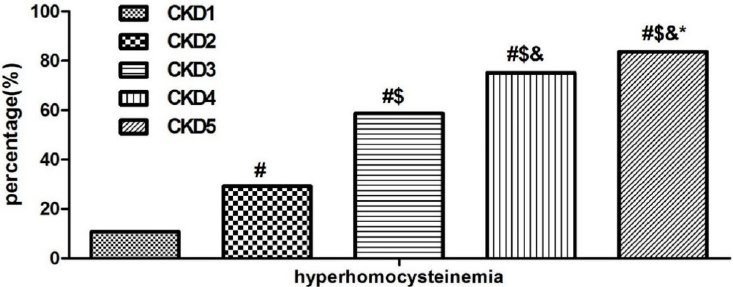
cIMT: Carotid intima ‐ media thickness; eGFR: Estimated glomerular filtration rate; LVMI: Left ventricular mass index; E/A: Peak velocities of early (E) and late (A) trans ‐ mitral flow and deceleration time; MDRD: Modification of Diet in Renal Disease.